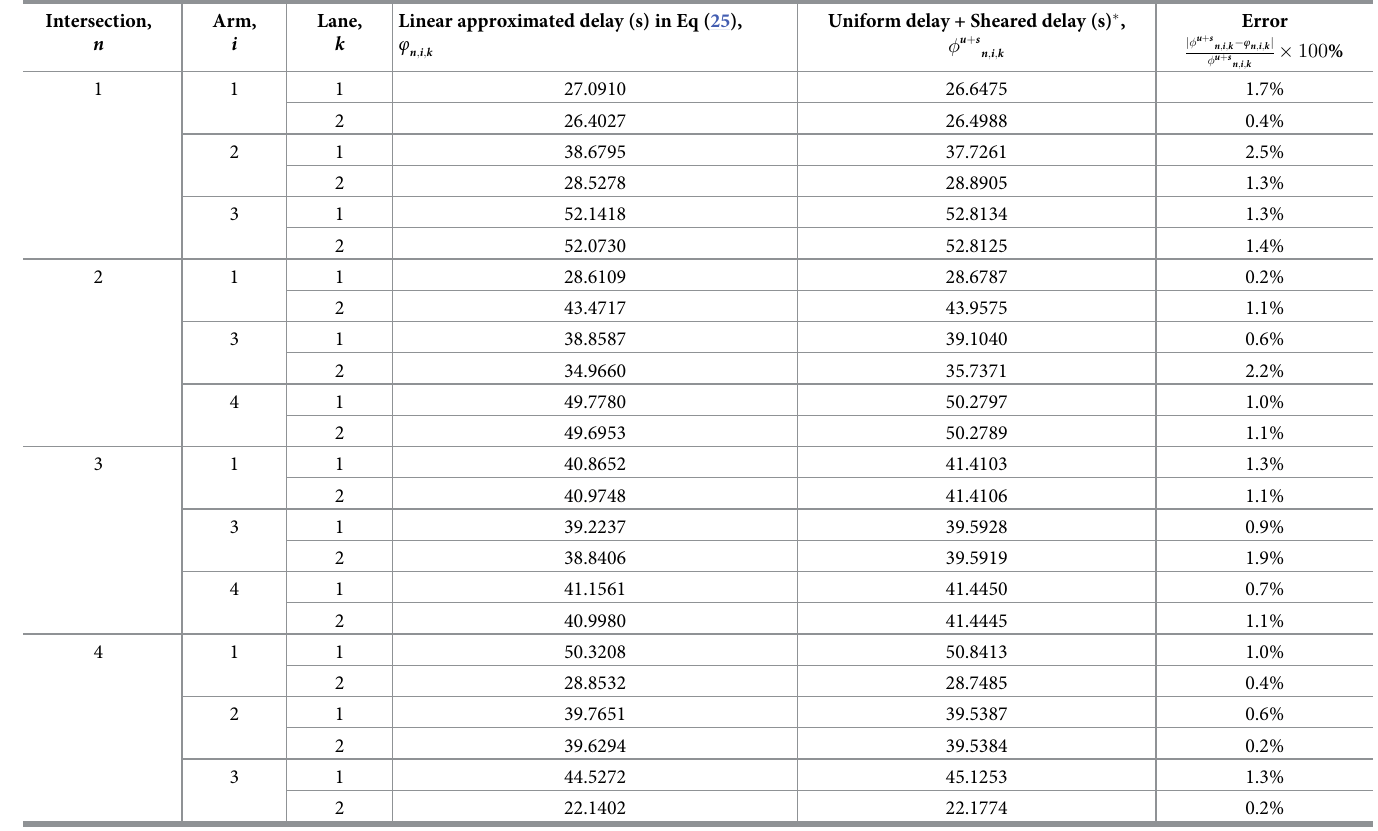
Table 6. Comparisons of the linear approximated delay and calculated total delay at the end of lane.